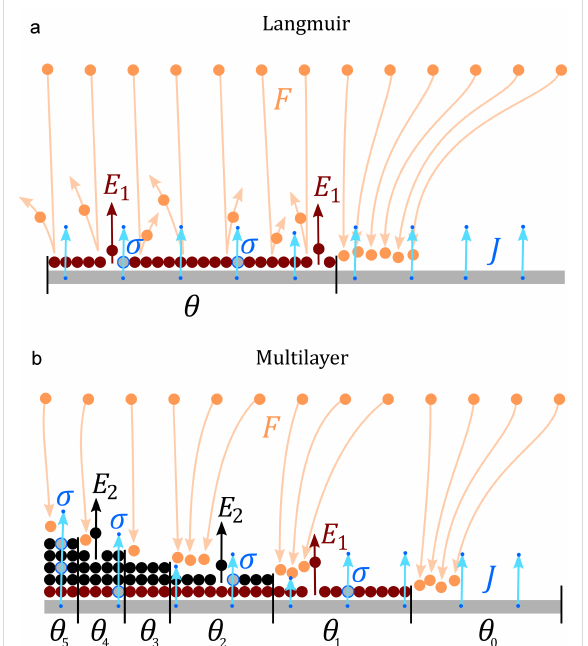
Figure 1: Schematic representation of the FEBID (a) Langmuir and (b) ML model. No diffusion is considered. Incoming precursor molecules with flux F are represented by orange spheres and arrows. Molecules adsorbed with energy E 1 (for Langmuir and first monolayer in ML model) are represented with red spheres, and upper monolayers (ML model) adsorbed with energy E 2 with black spheres. Electrons respon- sible for dissociation (here only represented as secondary electrons emitted from the substrate), with current density J and dissociation probability σ , are represented by blue dots and arrows. Molecules dis- sociated by electrons are shown as grey spheres. Only one mono- layer is permitted in the Langmuir model, with fractional coverage θ . Multiple layers are possible in the ML model, where the fraction of empty sites is θ 0 , and fraction of occupied sites with one, two, three, etc. adsorbed monolayers, is θ 1 , θ 2 , θ 3 , etc.